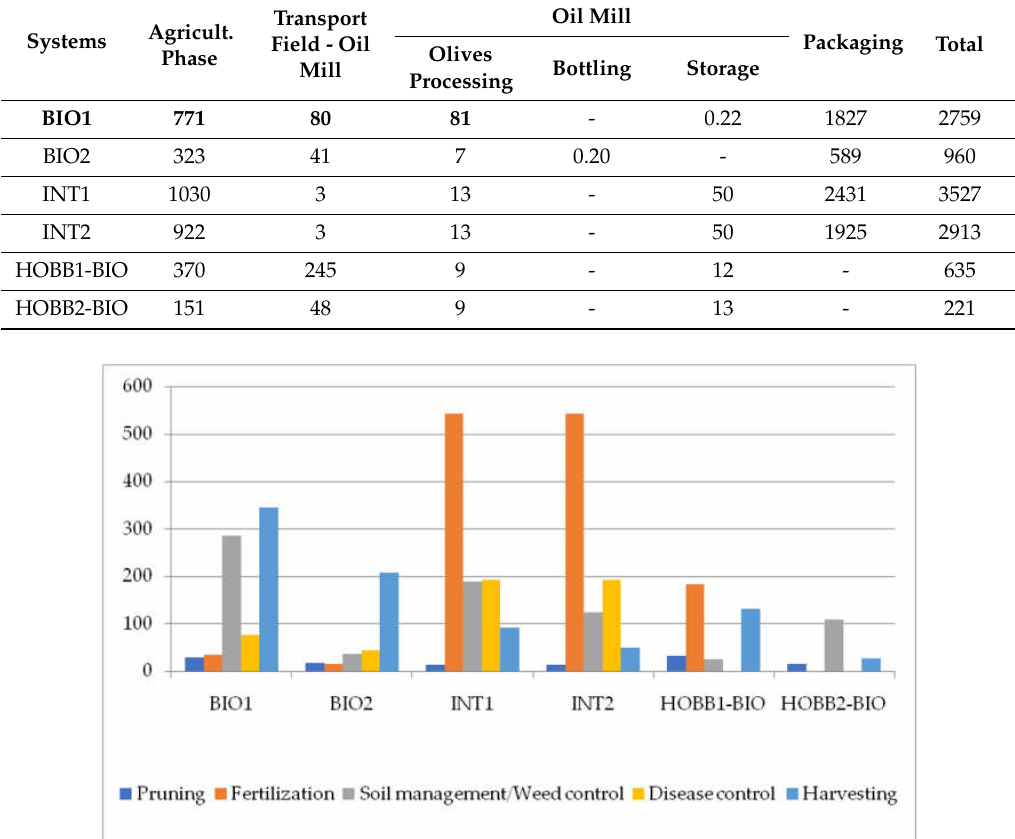
Table 8. Global warming (kg CO 2 eq ha –1 ) per phase of the production chain for each analyzed system.